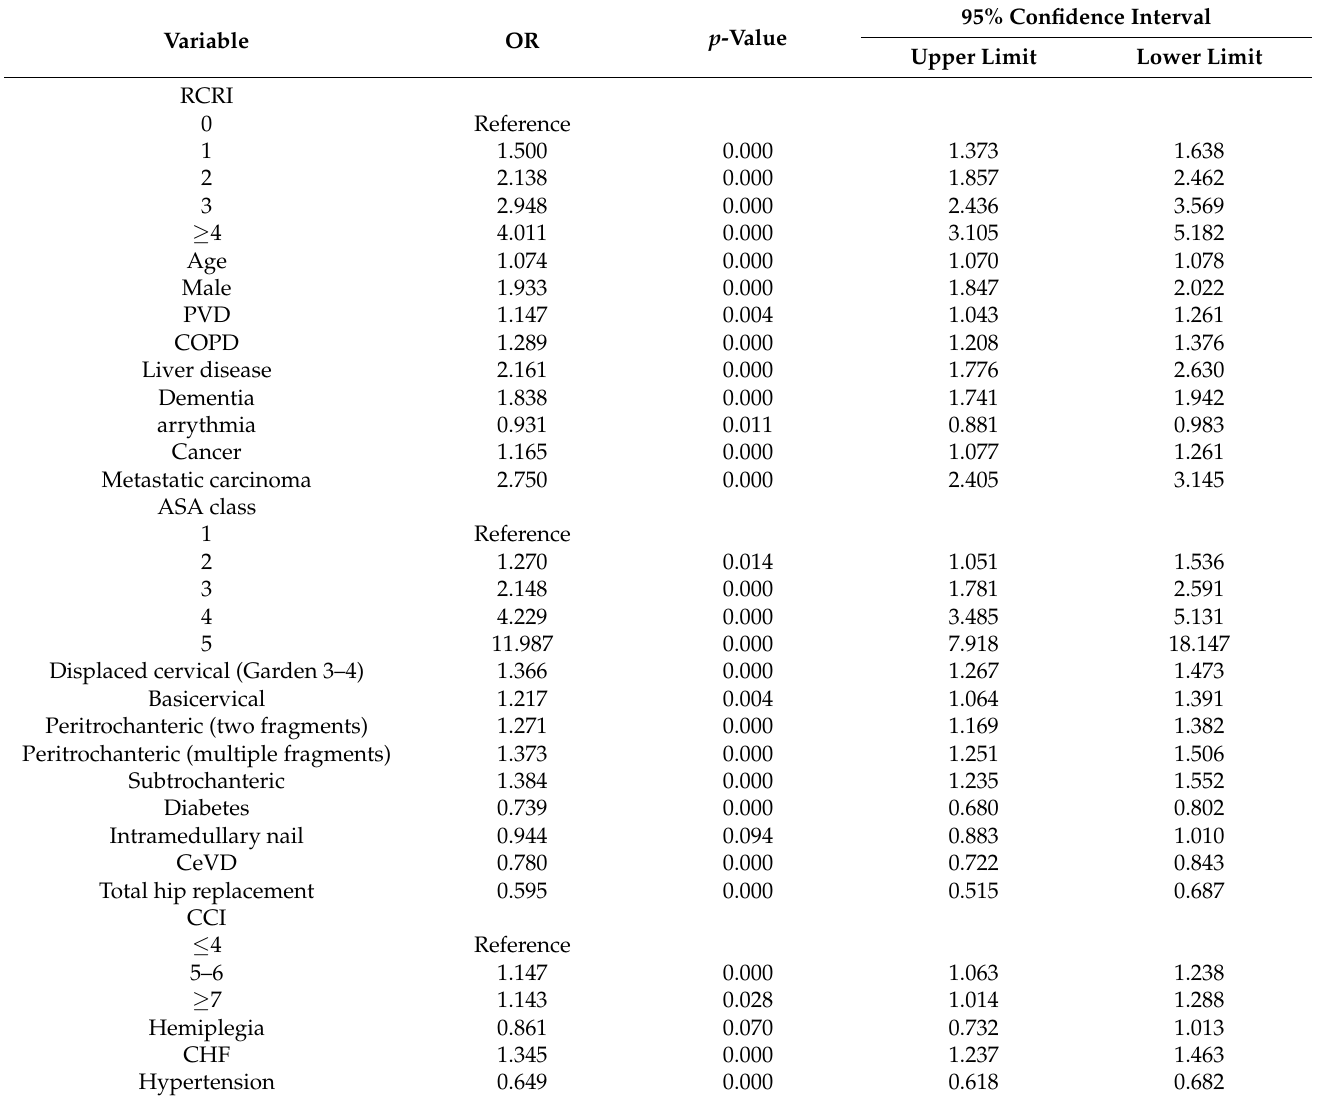
Table 3. Odds ratio (OR) of predictor variables for 30-day mortality after surgery (stepwise LR